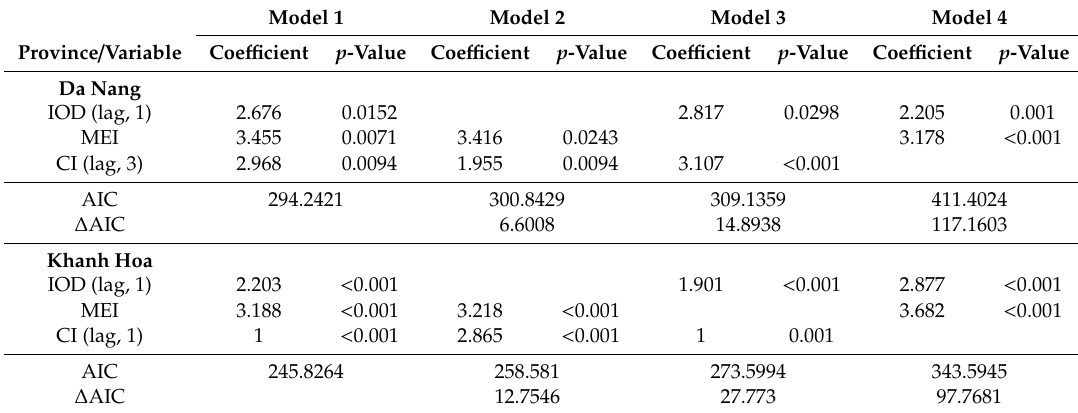
Table 3. GAM models of climate, mosquito index, and dengue incidence in Da Nang and Khanh Hoa Model